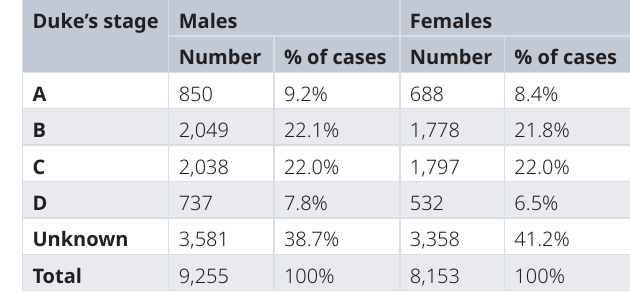
Table 13. Number of cases per Duke’s tumour stage at